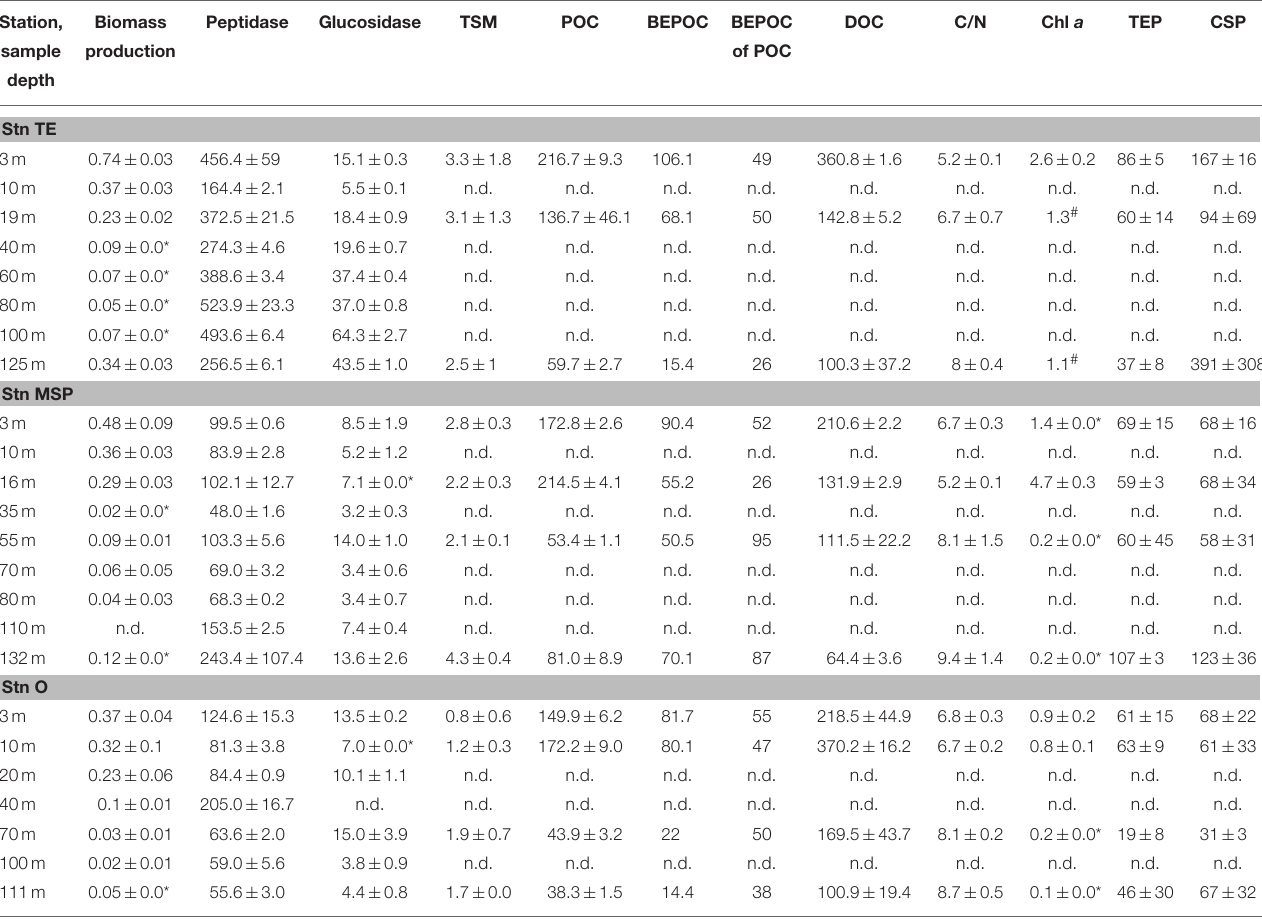
TABLE 2 | Water column profiles of biogeochemical parameters. Station, Biomass Peptidase Glucosidase TSM POC BEPOC BEPOC DOC C/N TEP CSP sample